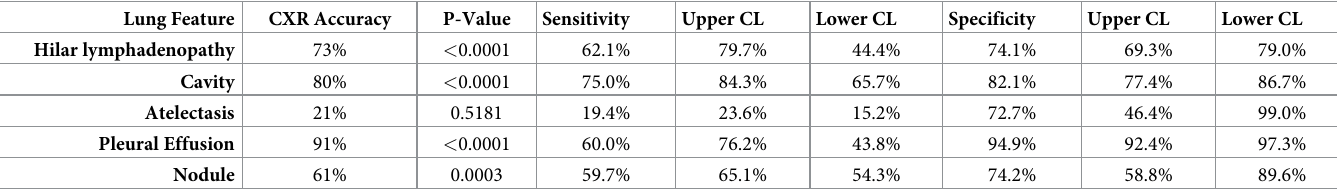
Table 2. 346 TBPP CXR Annotations versus Qure.ai Binary Prediction, Crosstabulation Summary Statistics. Lung